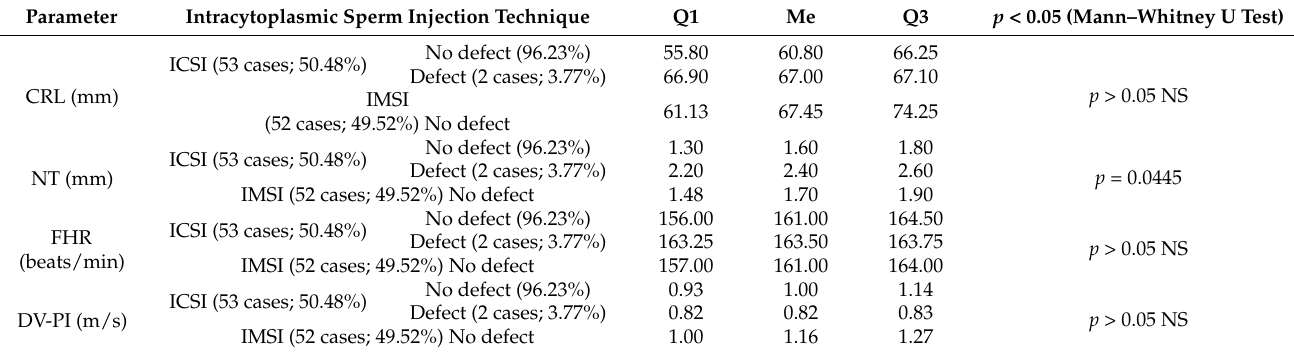
Figure 7. Median nuchal translucency depth amongst fetuses with a diagnosed developmental non- heart defect in comparison to fetuses in whom this possibility was ruled out in women who became pregnant as a result of in-vitro fertilization. * Statistically significant difference (Mann–Whitney U test; p < 0.05). Table 8. Assessment of the parameters describing the growth and health of the fetus with or without a congenital non-heart defect based on ultrasound examination in a group of women who became pregnant as a result of the intracytoplasmic sperm injection technique or the injection of morphologically selected sperm. Parameter Intracytoplasmic Sperm Injection